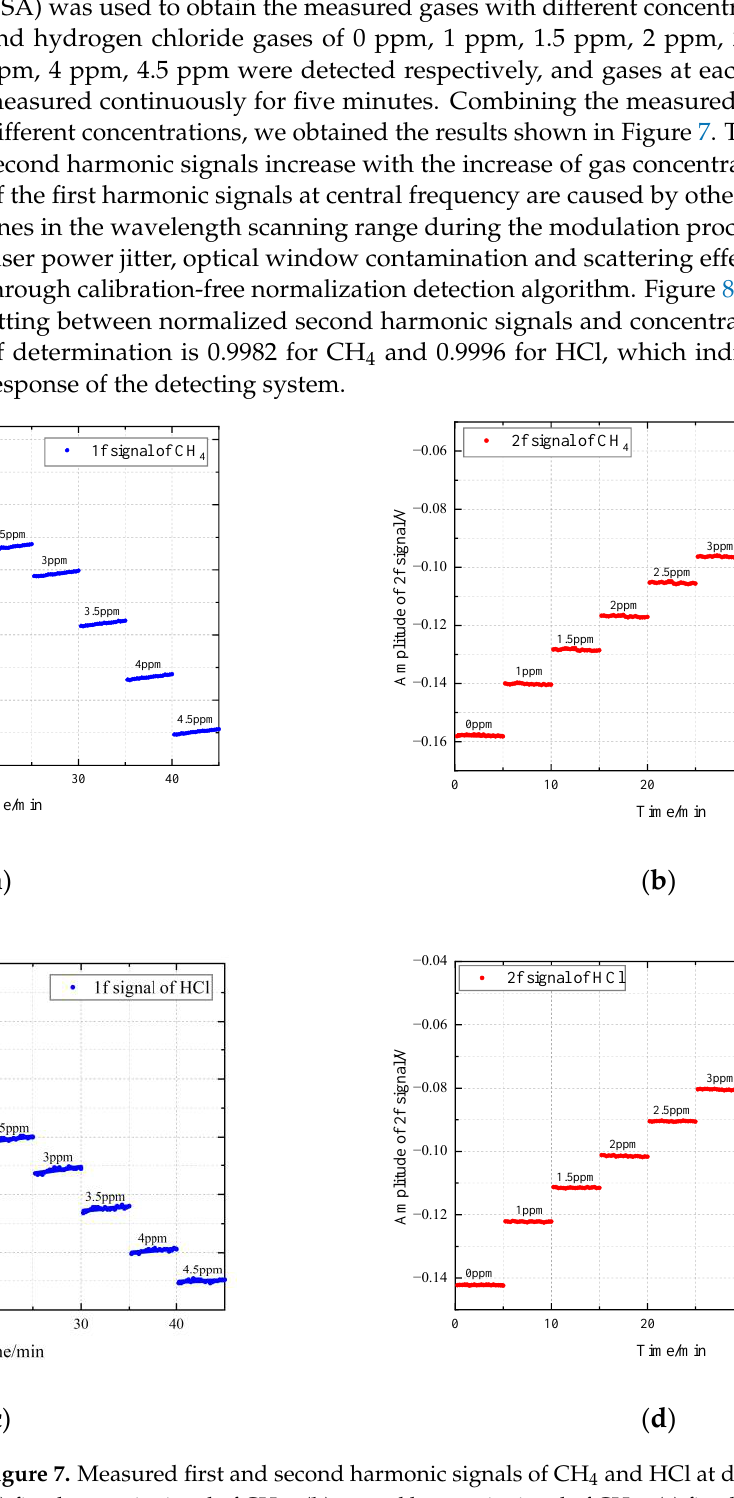
Figure 6. Relationship between modulation amplitude, modulation depth and 2f/1f ( a ) Influence on CH4 detection.; ( b ) Influence on HCl detection.